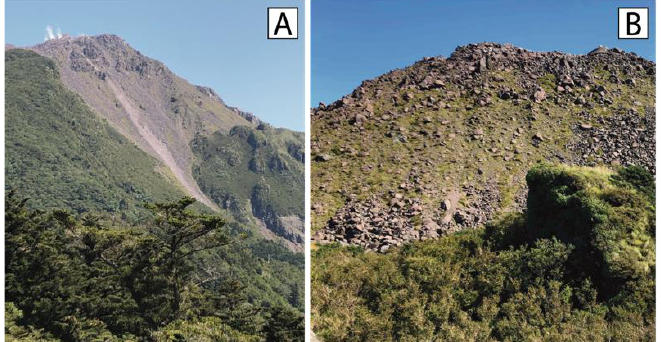
Figure 9. Field photos taken by the lead author on 2 October 2021. ( A ): Eastern flank of the volcano. The background shows the eastern flank with the area affected by the block and ash flows and the lava dome still clearly demarcated. Only a light covering of grass and shrubs are present in that area. The foreground shows trees growing on the lower parts of the south-western slopes. ( B ): Southeast side of the summit (lava dome) area of the volcano. The background shows the summit area covered by a light smattering of grasses. In comparison, the foreground shows a more forested area (trees) on the lower southeast slopes of the volcano.